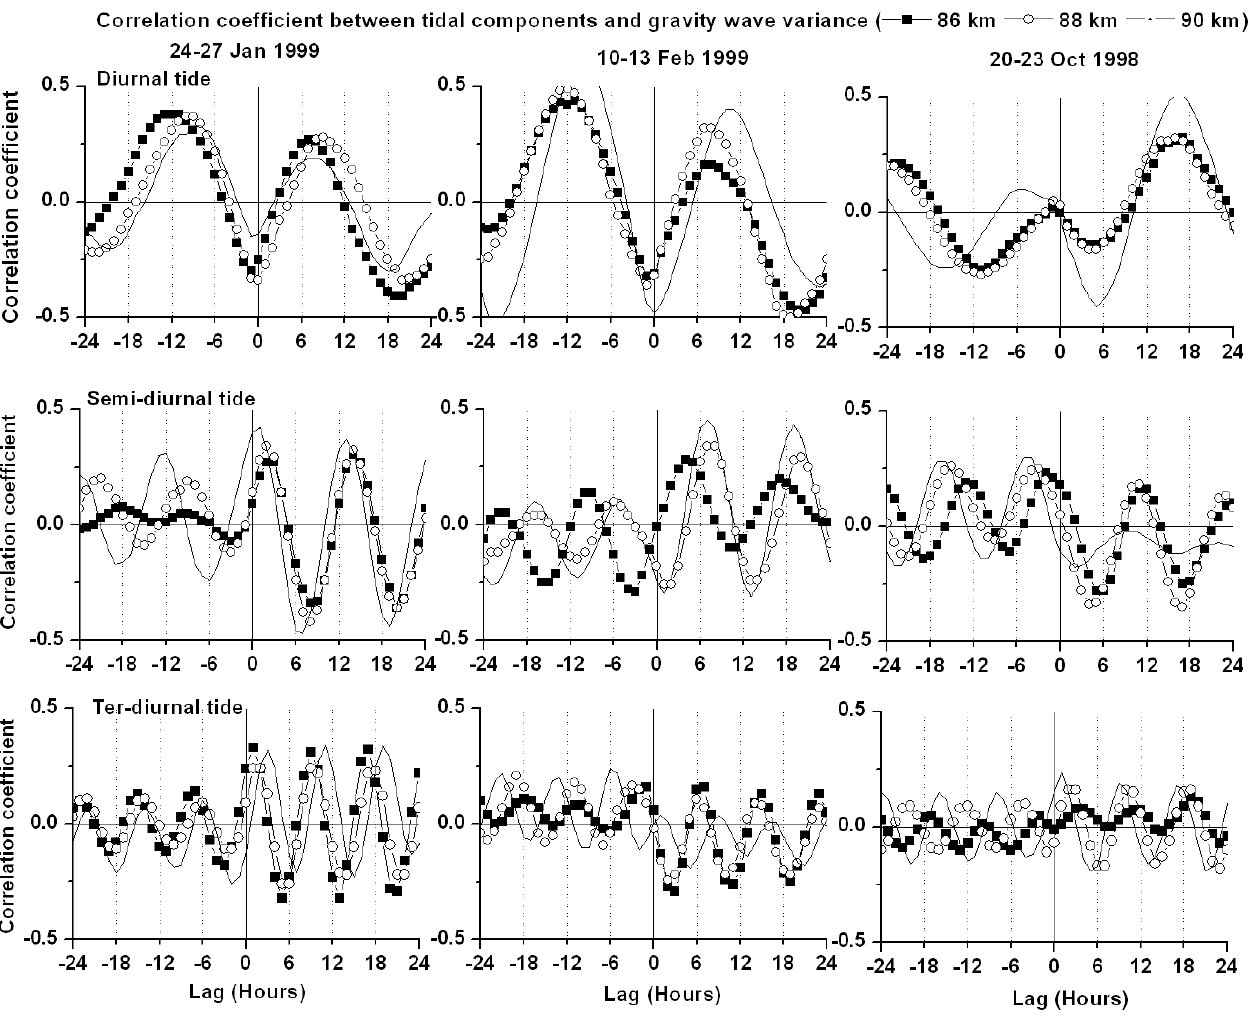
Fig. 4. Correlation coefficient between tidal components and gravity wave variances in zonal winds at